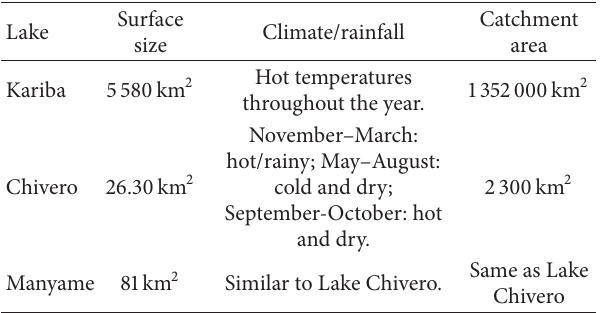
Table 1: Description of Lake Chivero, Lake Kariba, and Lake